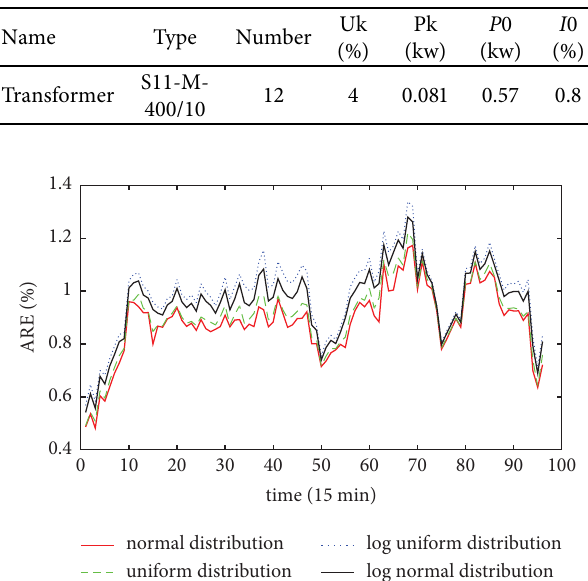
Table 2: Transformer information.